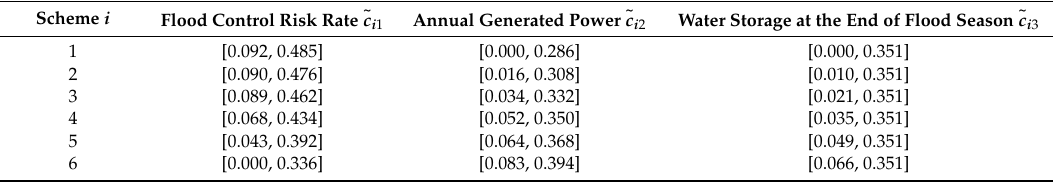
Table 7. Weighted standardized interval number decision matrix (cid:101) C .